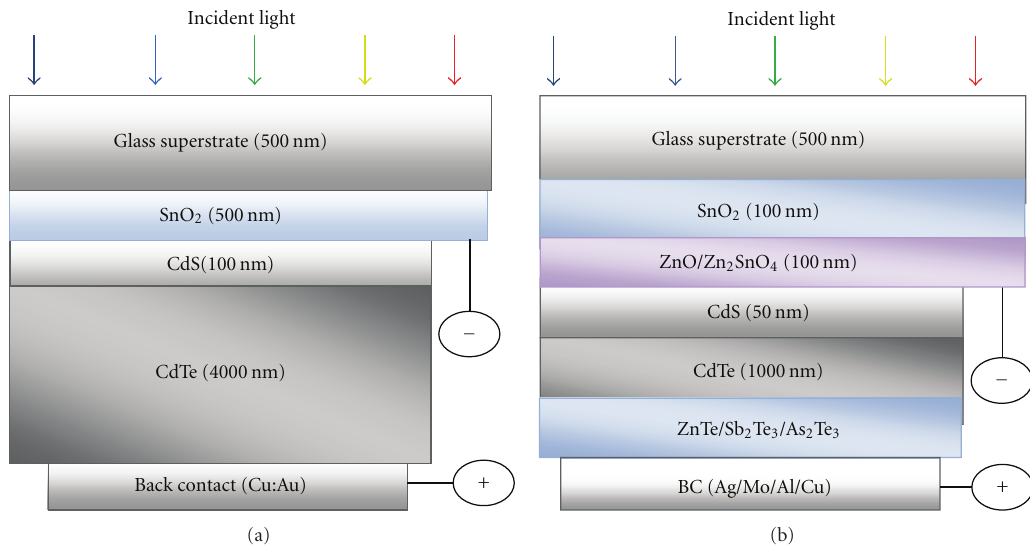
Figure 1: Structures of the CdTe solar cells: (a) conventional baseline case structure and (b) modified structure for higher performance.